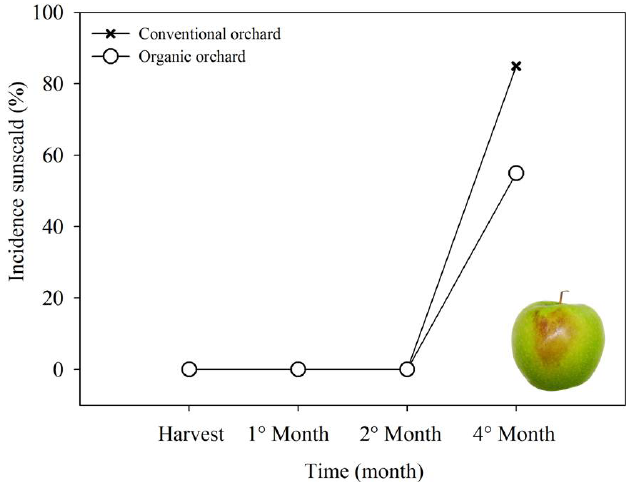
Fig. 7: Incidence of sunscald in apples cv. Granny Smith, after 4 months of cold storage.